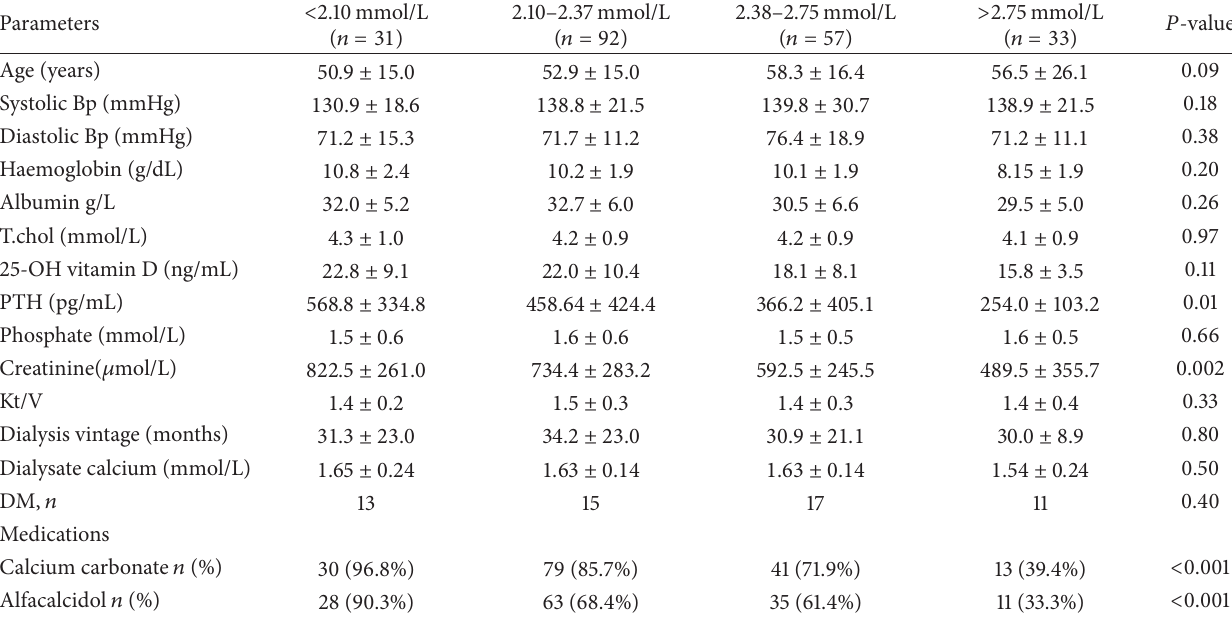
Table 3: Patient characteristics by serum calcium